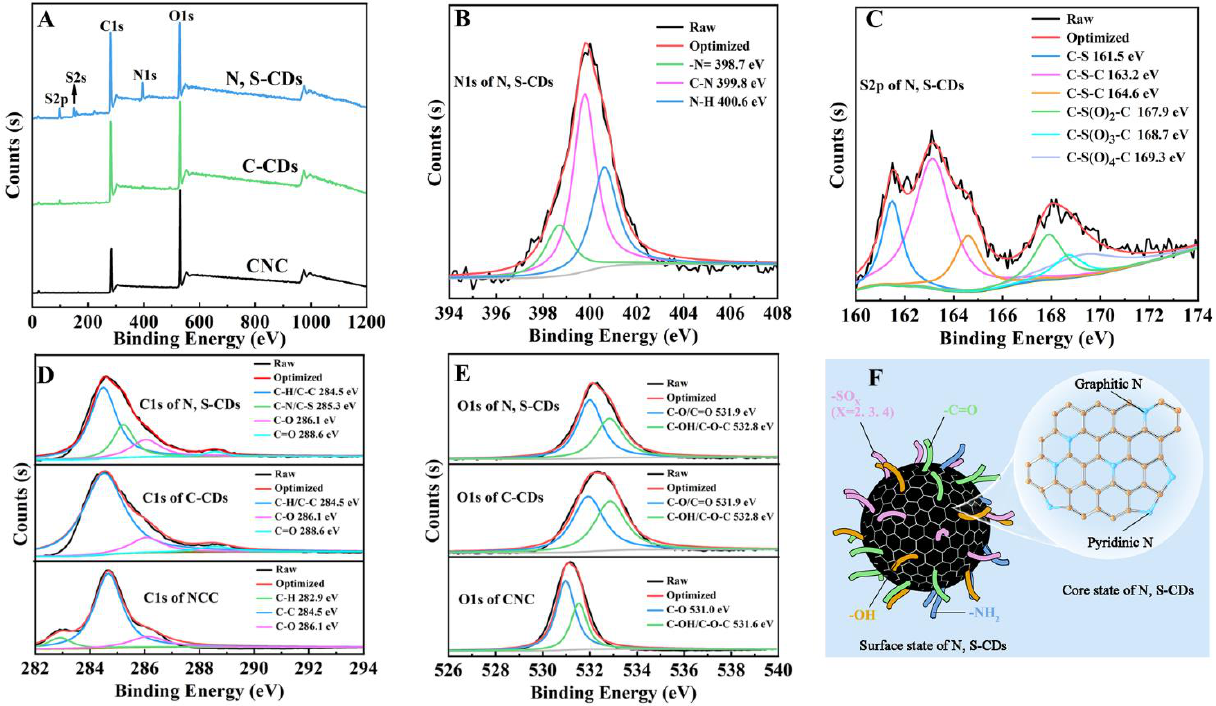
Figure 3. XPS spectra of CNC, C-CDs and N, S-CDs ( A ); high-resolution N1s ( B ) and S2p ( C ) spectra of N, S-CDs; high-resolution C1s ( D ) and O1s ( E ) spectra of CNC, C-CDs and N, S-CDs; the schematic diagram ( F ) of the surface and core state of N, S-CDs.